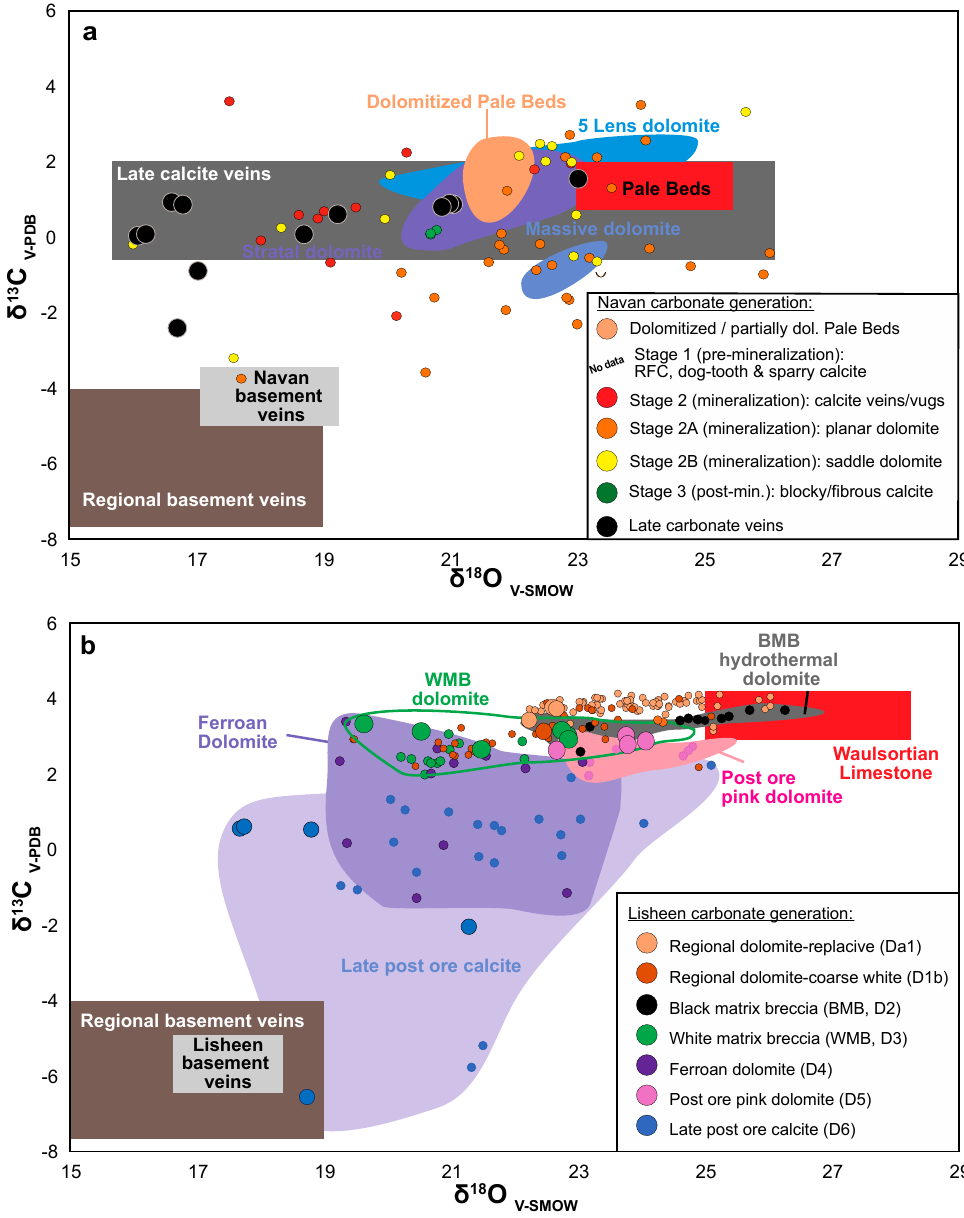
Figure 9. C and O isotope compositions of carbonates from the Navan ( a ) and Lisheen ( b ) deposits, expressed conventionally as δ 13 C and δ 18 O values. New data (Table A2) are shown as larger symbols; small symbols include historical data associated with mineralization; and shaded fields represent historical data associated with both dolomitized and un-dolomitized Pale Beds to improve the clarity of the figure [11,43,48–50].